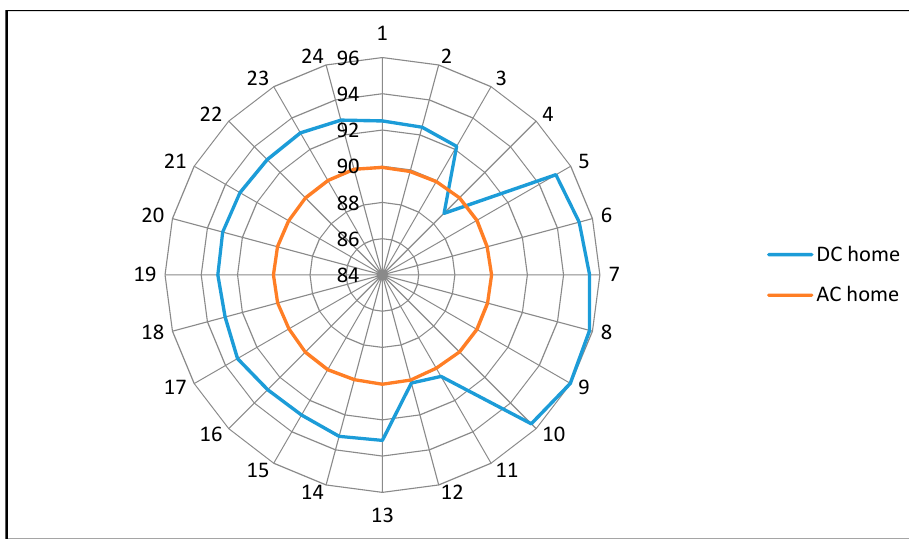
Figure A2. Building efficiencies when adopting the AC or DC systems.